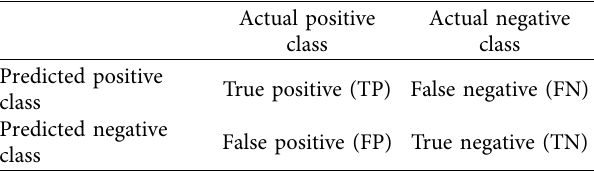
Table 3: Confusion matrix of two-classification problems